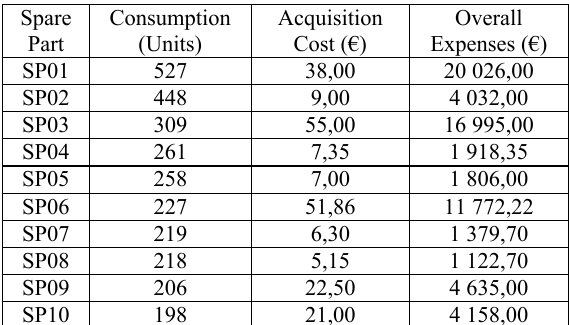
Table 1. Spare part consumption by number of requests and respective acquisition cost, and overall expenses for the first nine months of